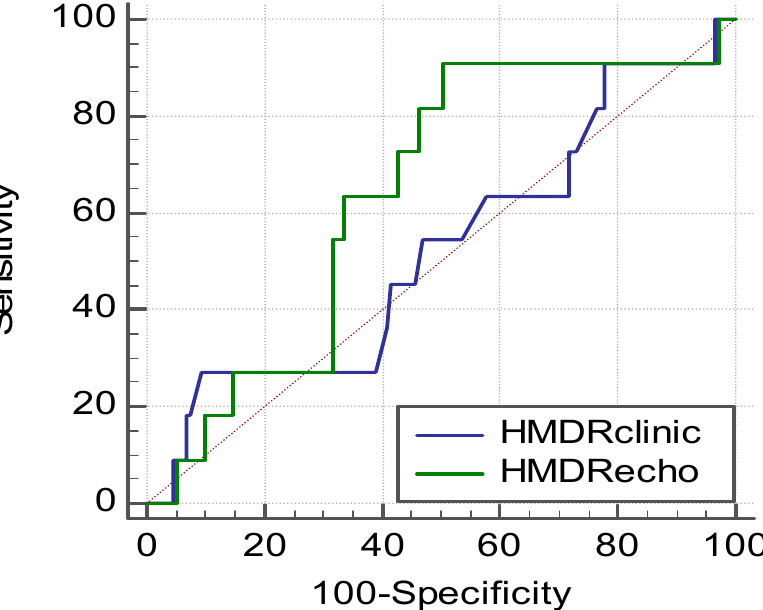
Figure 4. Receiver Operating Characteristics curves for HMDR clin and HMDR echo as discriminative variables and grades III and IV Cormack–Lehane as outcome variables.